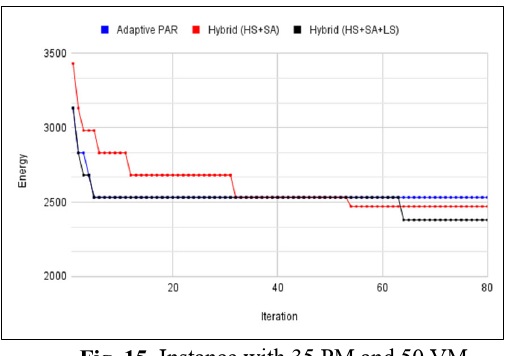
Fig. 15. Instance with 35 PM and 50 VM Fig. 16. Instance with 50 PM and 120 VM